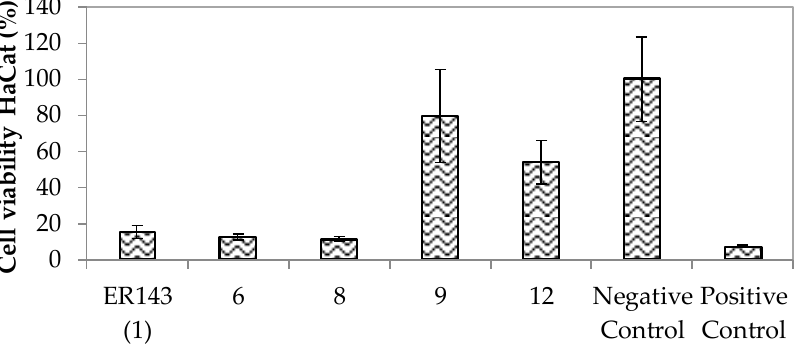
Figure 1. Cell viability assay at 50 µM concentration of compounds ER143 (1) , 6 , 8 , 9 and 12 in HaCaT cells for 24 h of exposition time.